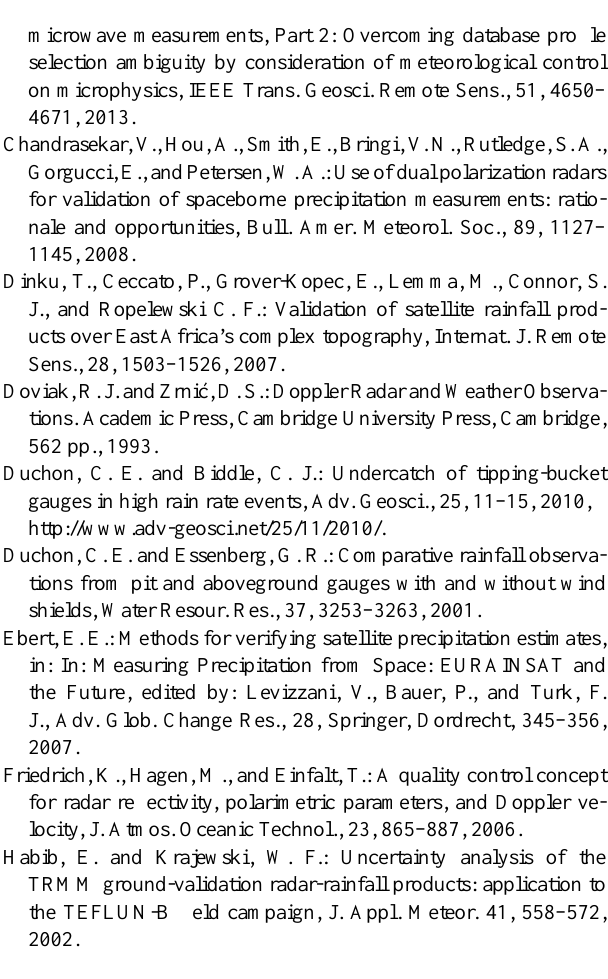
microwave measurements, Part 2: Overcoming database profile selection ambiguity by consideration of meteorological